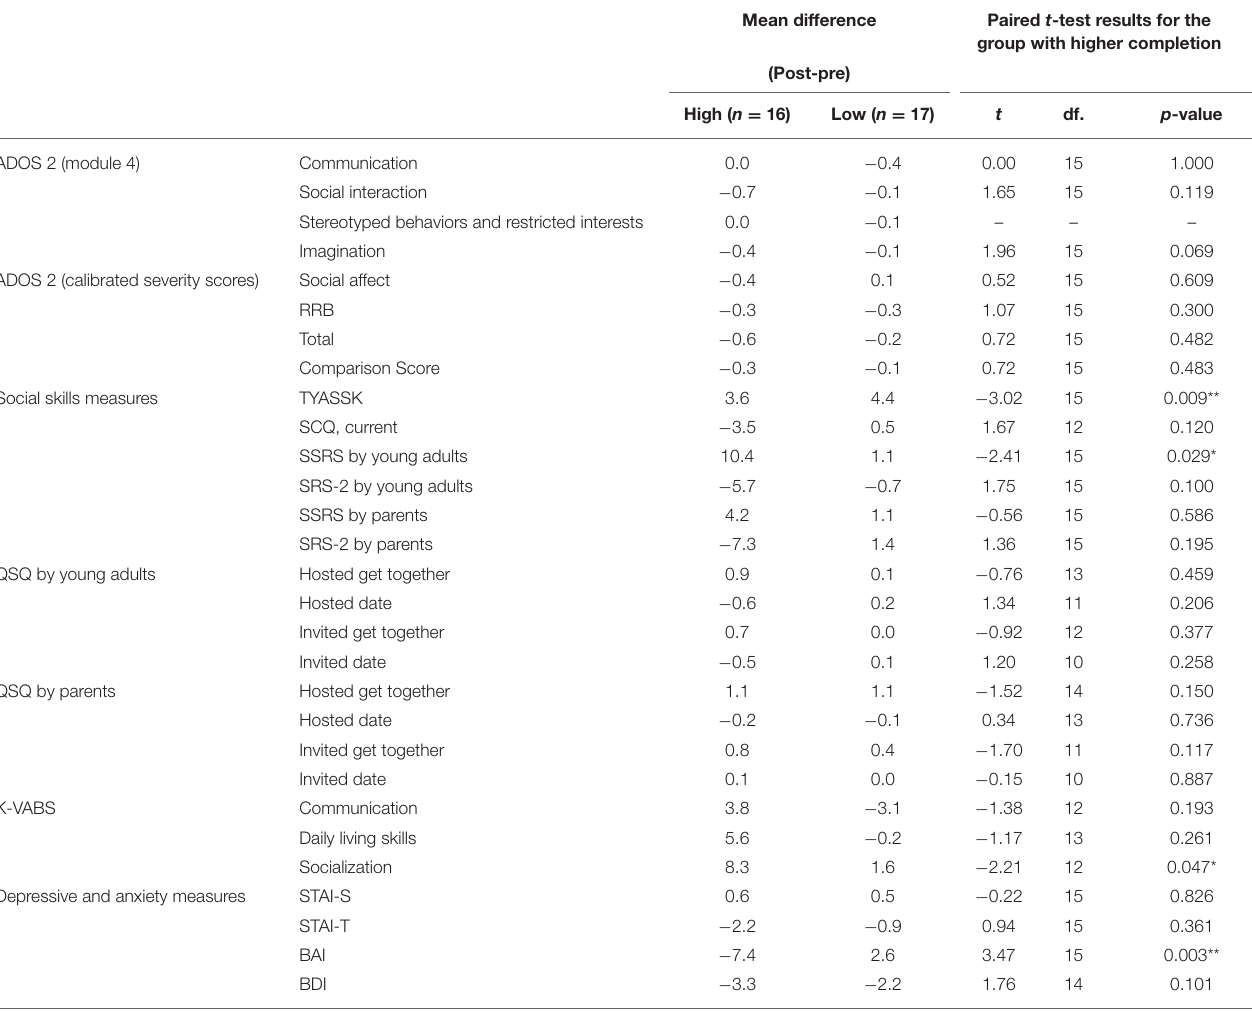
TABLE 5 | Comparison of treatment effects according to homework completion rate (below/above median).